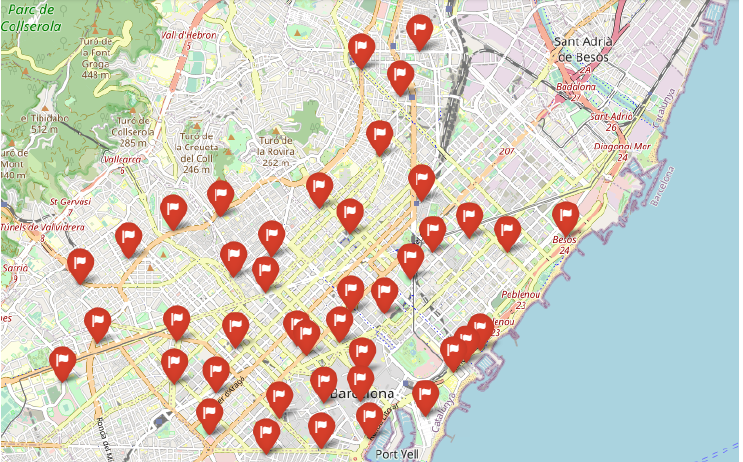
Figure 7. Potential Facilities